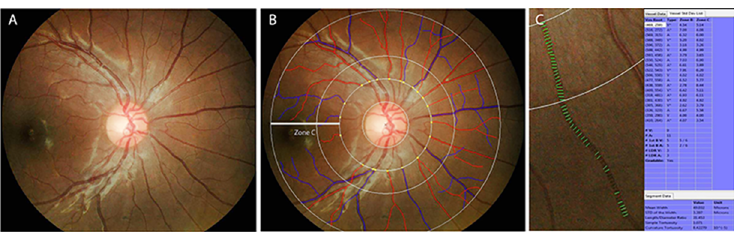
Fig 1. Fundus photo centered on the optic disc in Singapore I Vessel Assessment (SIVA) software. Panel A shows an example of a digital fundus photo pre-processing. Panel B shows a screenshot of the SIVA system. All retinal vessels greater than 25 um in diameter located between one-half to two disc diameters from the optic disc margin (i.e. in Zone C) are outlined and their edges marked using a pixel density histogram. The retinal arterioles are outlined in red, while the venules are outlined in blue. In Panel C, the green lines overlying the segment of a vessel are referred to as ‘covers’. A minimum of 5 covers are needed; based on these, the software will then provide an average of the mean retinal arteriolar and venular calibers.